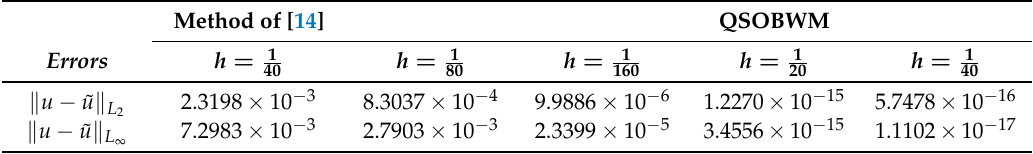
Table 4. Comparison of the errors of QSOBWM and the method in [14] for Example 2.